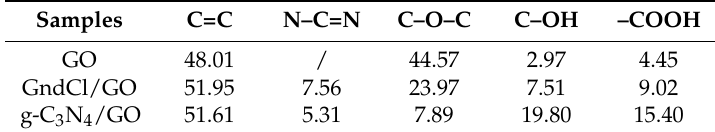
Figure 4. ( a ) XRD diffraction pattern of g-C 3 N 4 /rGO/MnO 2 ternary nanocomposite. ( b ) Raman spectra of GO, g-C 3 N 4 /rGO and g-C 3 N 4 /rGO/MnO 2 ternary nanocomposite.